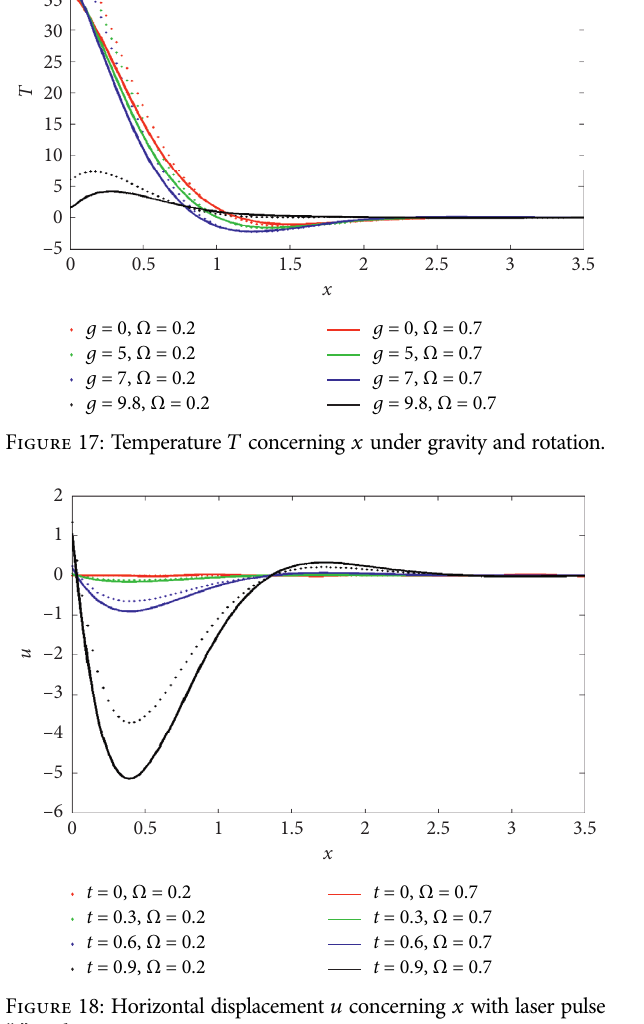
Figure 21: Stress σ x with laser pulse “ t ” and rotation. zz concerning